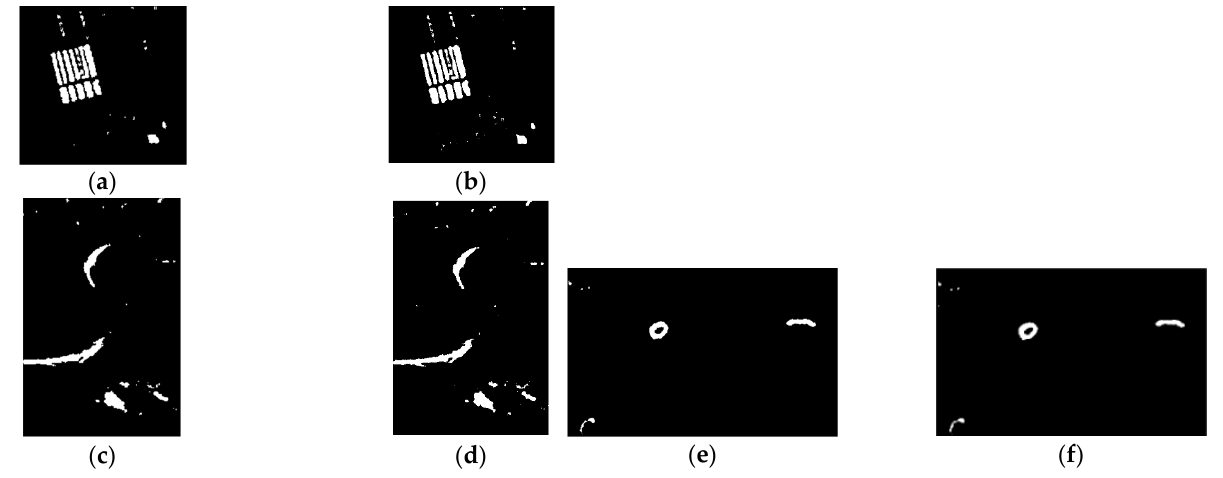
Figure 4. Change detection maps obtained by supervised and proposed methods on three SAR data sets. Farmland data set: ( a ) supervised method, ( b ) JDBN; River data set: ( c ) supervised method, ( d ) JDBN; Coastline data set: ( e ) supervised method, ( f ) JDBN. Table 1. Quantitative evaluation of the three data sets.